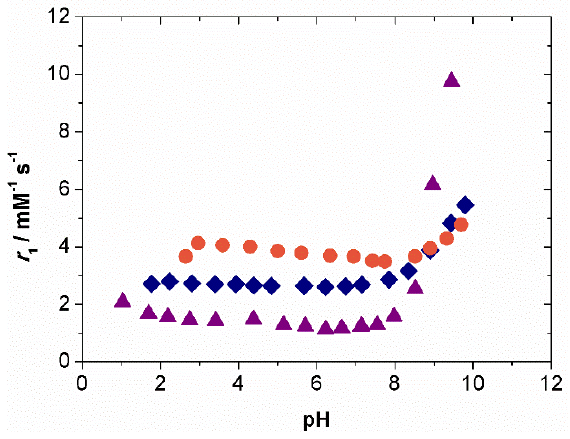
Figure 1. pH dependence of r 1 at 20 MHz and 298 K for aqueous solutions of GdL1 ( ♦ , 2.9 mM), GdL2 (●, 2.7 mM), and GdL3 ( ▲ , 1.8 mM).